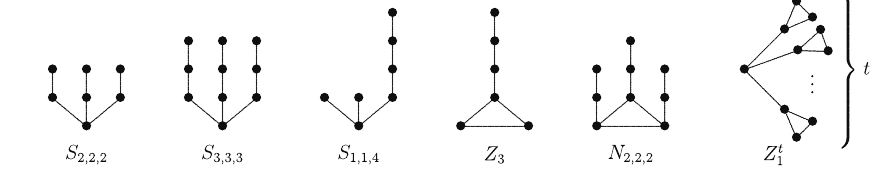
Figure 1: The graphs S